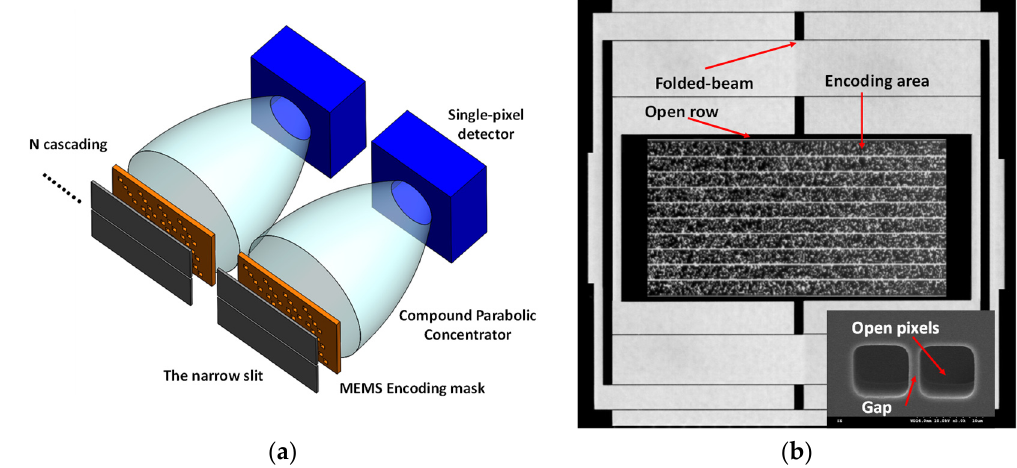
Figure 13. ( a ) The schematic drawing of a MEMS vibrating mask with cascaded structures, with compound parabolic concentrator glued on single-pixel detector [132]; ( b ) The microscopic picture of the compressive sensing (CS) vibrating mask with the inset showing the SEM image of the pixel structures [133].